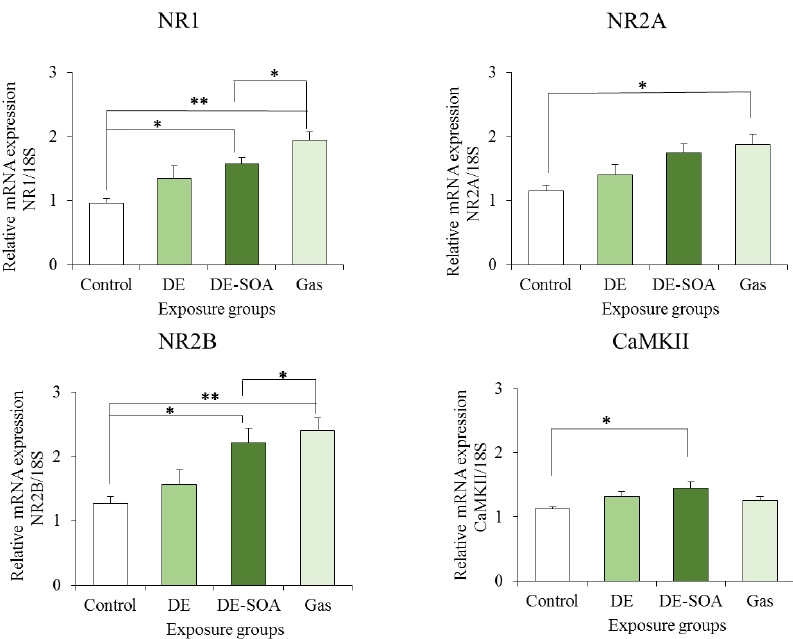
Figure 4. Effects of DE or DE-SOA exposure on the gene expressions of the NMDA receptor subunits NR1, NR2A, and NR2B, and of CaMKII in the hippocampi of the preweaning mice ( n = 6–8, ** p < 0.01, * p < 0.05 vs. control).